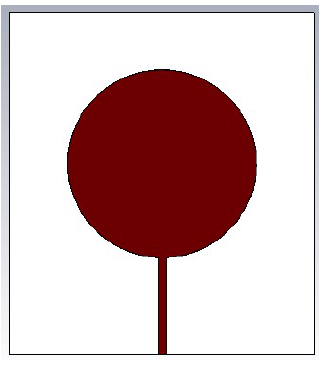
Figure 4: Patch without CRR.